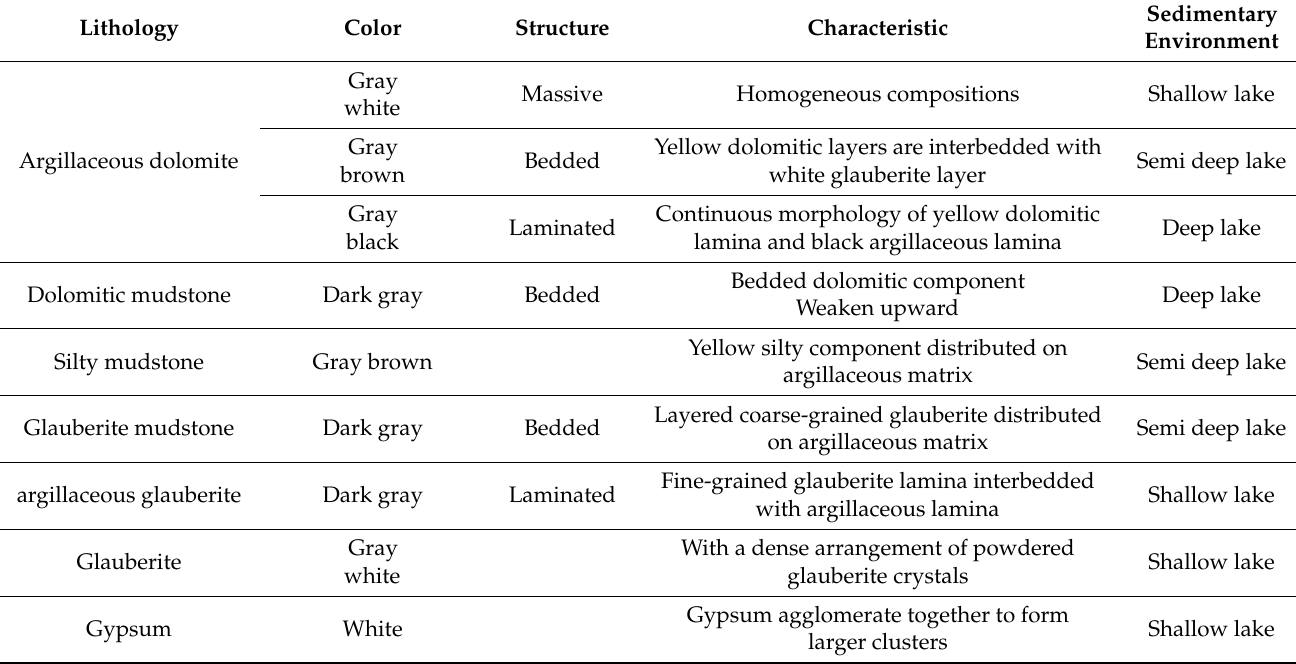
Table 1. Characteristic of different